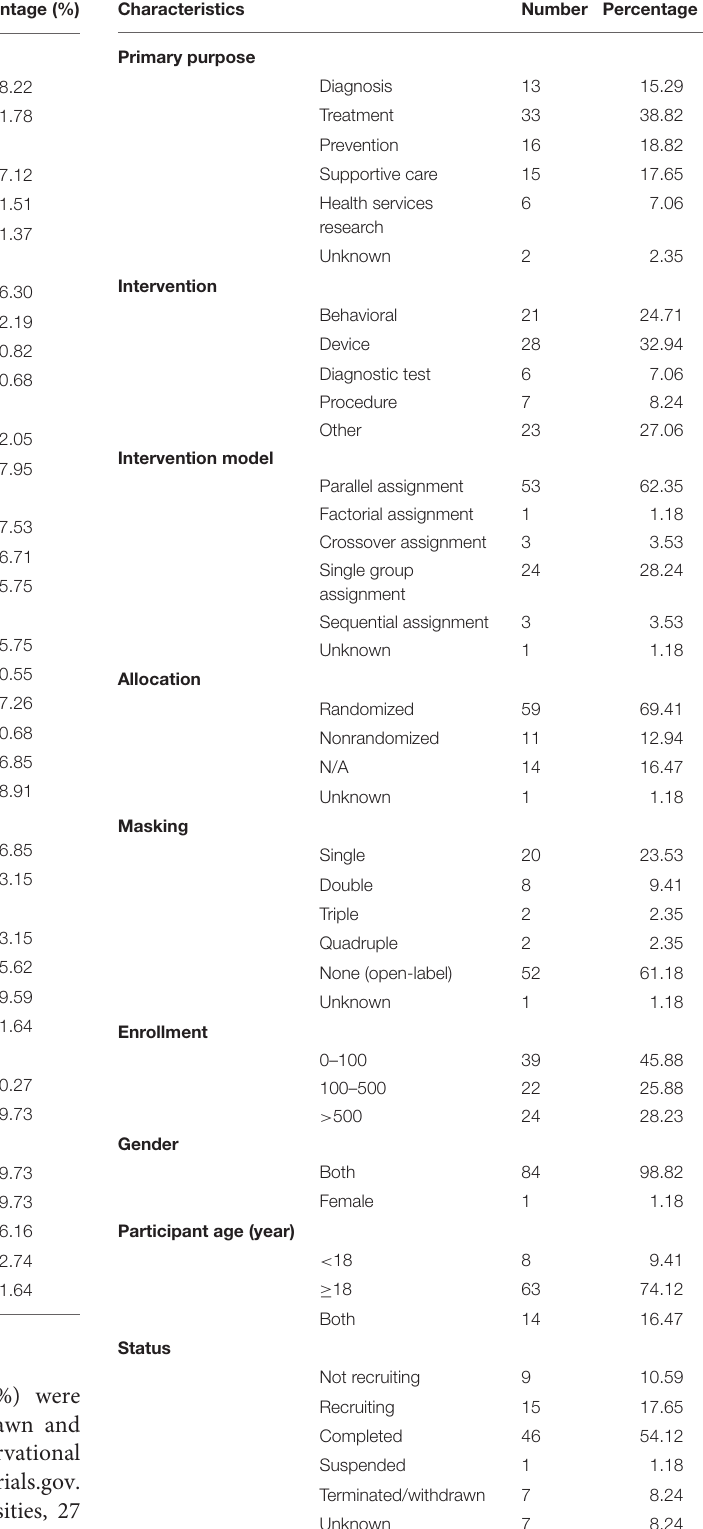
TABLE 2 | Designs of 85 interventional trials registered with